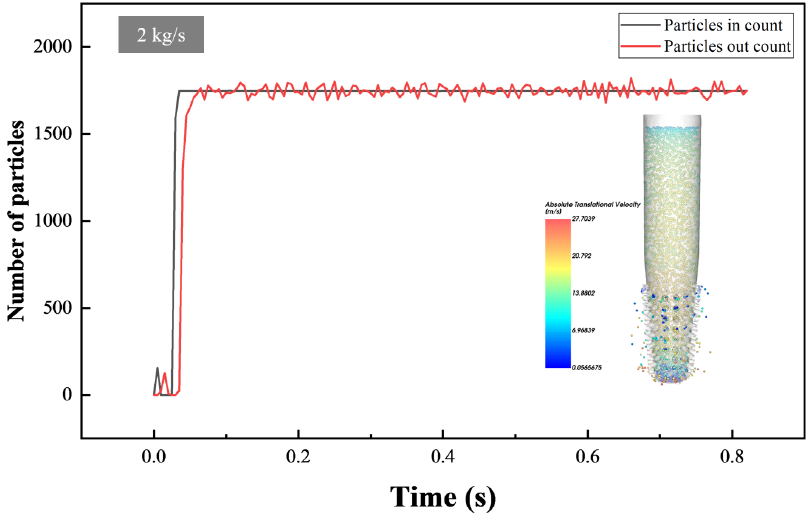
Figure 15. 1.6 mm LCMs entering at 2 kg/s mass flow.